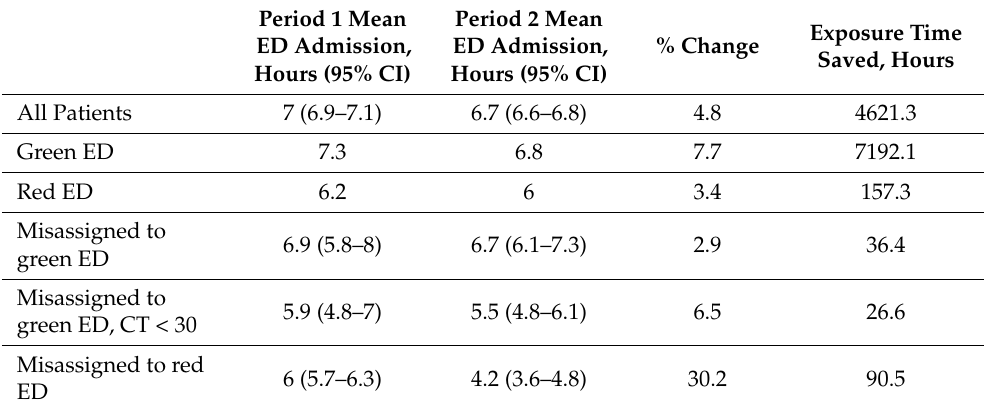
Table 3. Mean ED admission length (hours), change percentage between two study periods, and exposure time saved the daily average and percentage of ED patients assigned to the green/red EDs during research periods 1 and